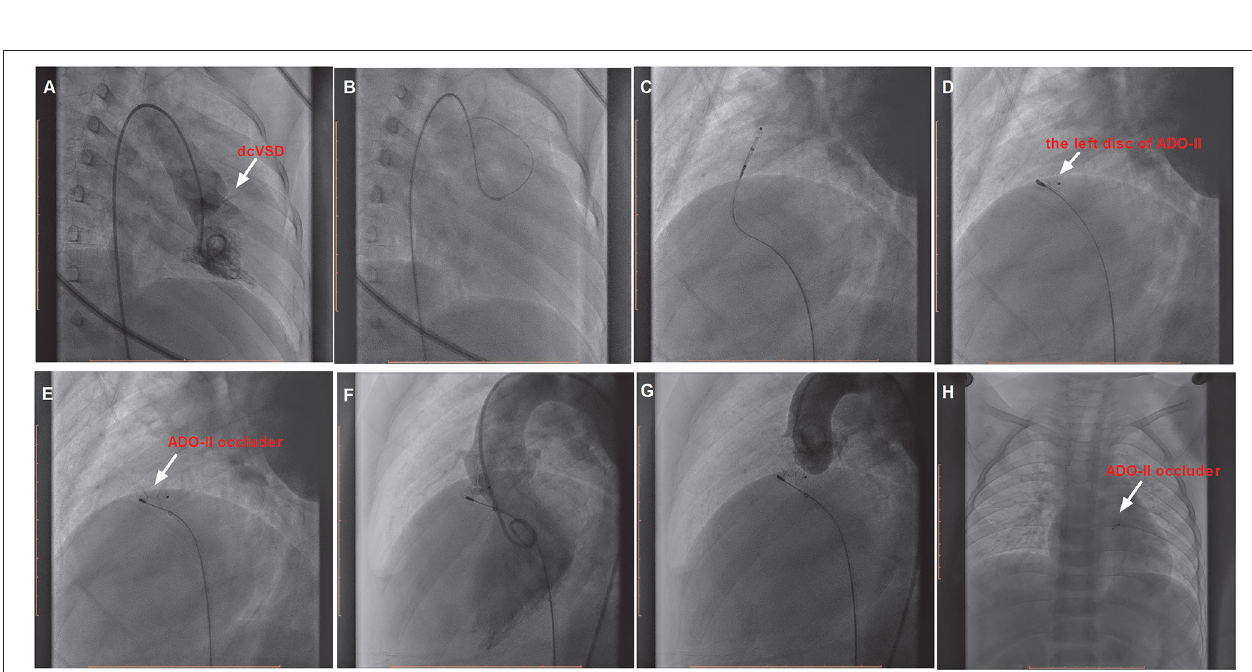
FIGURE 2 | The procedure of transfemoral occlusion of the dcVSD using the ADO-II device via the retrograde approach. (A) Confirms the location of the deVSD (arrow) by left ventriculography before device closure of it, and (B) Demonstrates the finding of aortography without AR before the procedure. (C–F) Show the processes of the transcatheter technique. (G) Shows the operational success and no RS by left ventriculography, and (H) Shows no AR after device implantation by aortography. dcVSD, doubly committed subarterial ventricular septal defect; AR, aortic regurgitation; RS, residual shunt.